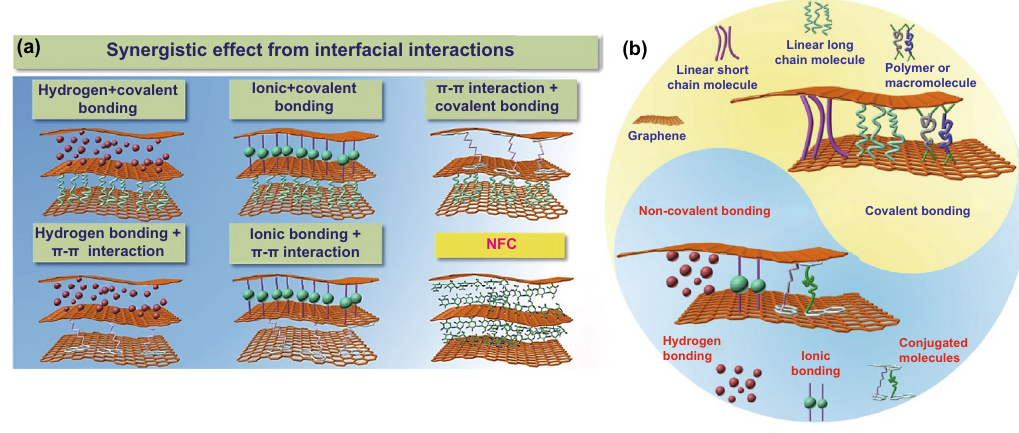
Fig. 6 a , b Interfacial interaction categories in graphene-based nanocomposites, including non–covalent and covalent bonding. Reproduced with permission from Ref. [108] Copyright © 2017 Elsevier